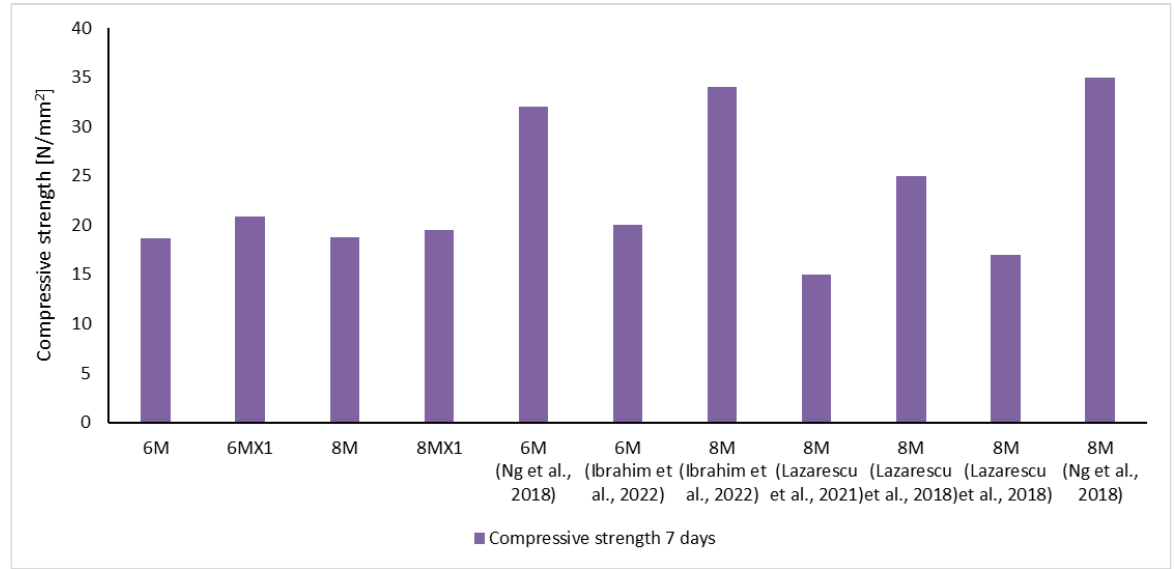
Figure 4. Comparative analysis of experimental results with literature reports [50,61,62,64].